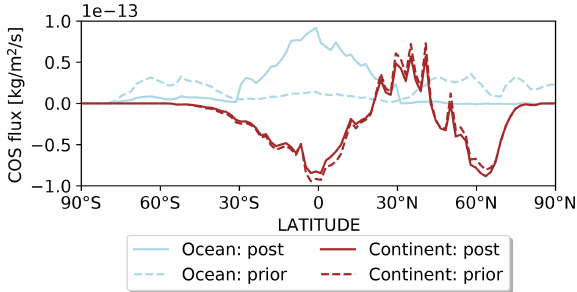
Figure 7. Latitudinal distribution of the prior (dashed line) and pos- terior net CO 2 fluxes from the terrestrial vegetation (full line). Veg- etation fluxes are the sum of GPP and respiration fluxes. The fluxes have been averaged for the years